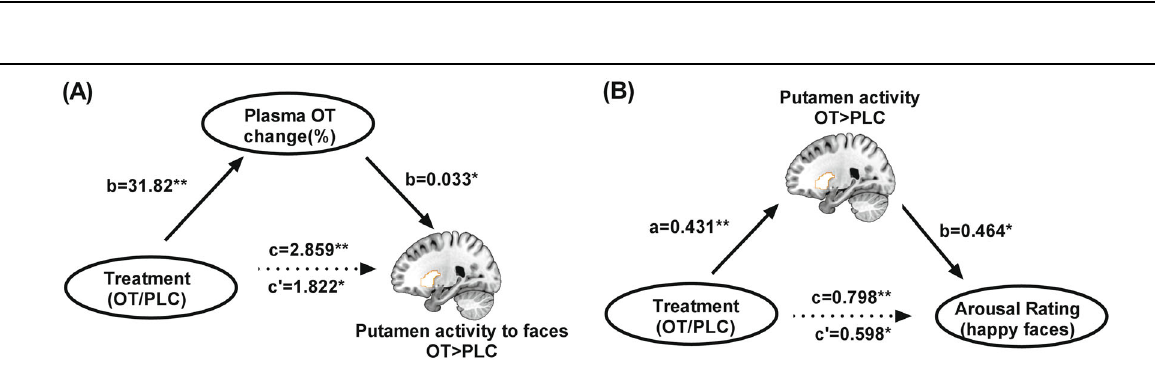
Fig. 3 Mediation analysis for putamen responses to faces and oxytocin (OT) concentrations and behavior ratings. A Plasma OT concentration % change partially mediated the oxytocin treatment effect on putamen responses to all face emotions. B Putamen responses partially mediated the OT treatment effect on arousal rating to happy faces. PLC placebo. * p < 0.05, ** p <